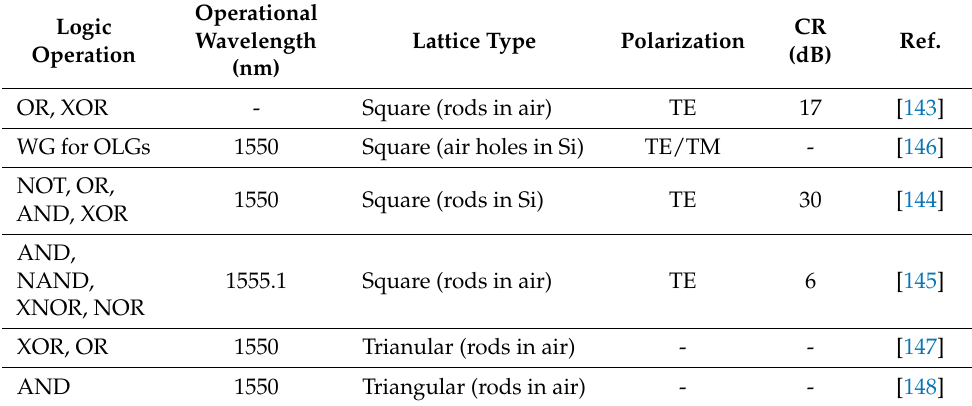
Table 1. Evaluation of different kinds of non-PBG-based all-OLGs.